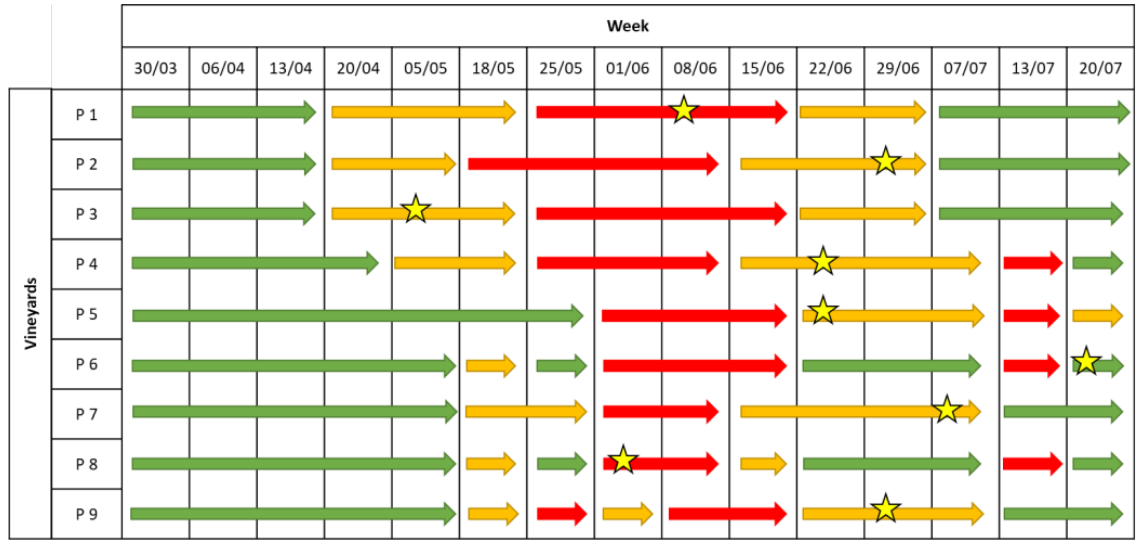
Figure 2. Levels of infection risk signalled by the EPI model. Coloured arrows indicate different levels of infection risk: red indicates a high infection risk, yellow indicates a medium infection risk, and green indicates a low infection risk. The stars indicate the moments when the first symptoms appeared in the field.